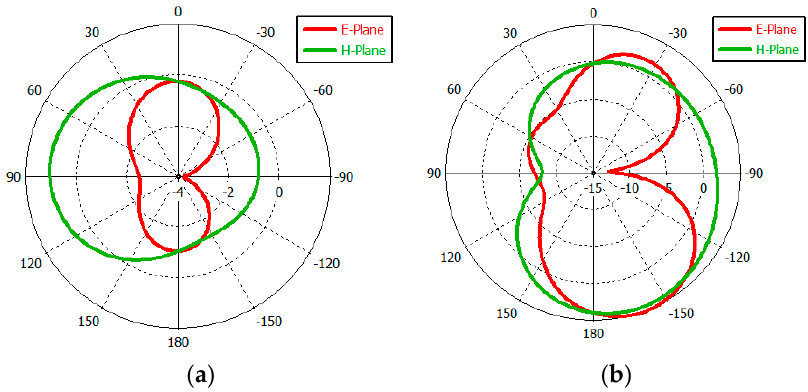
Figure 9. Simulated two-dimensional radiation pattern ( a ) at 2.45 GHz; ( b ) at 5.8 GHz.